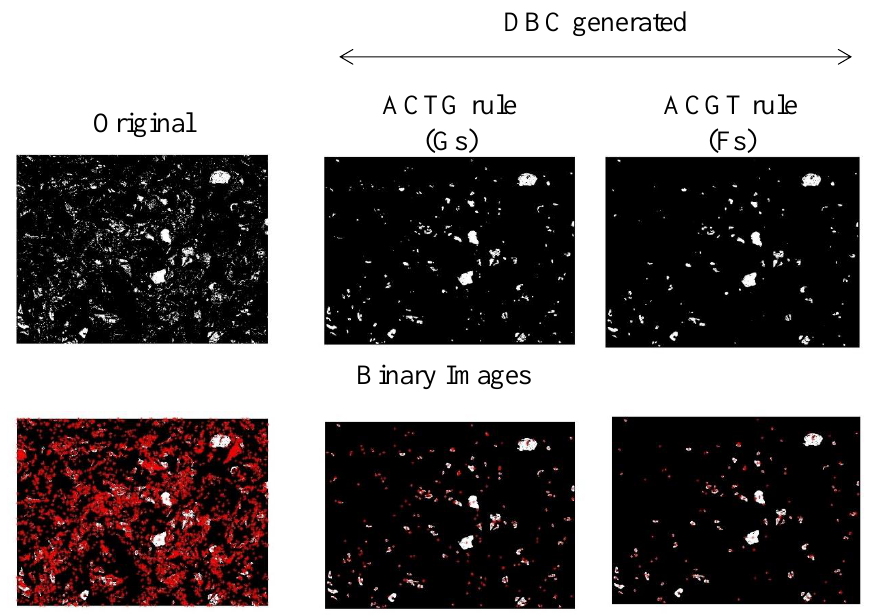
Figure 10. Binary images showing the efficacy of DBC.